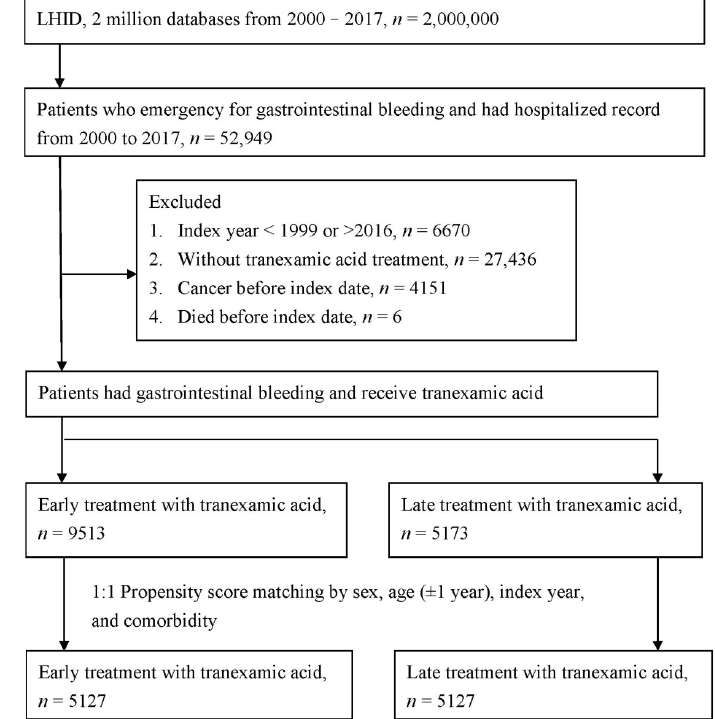
Figure 1. Study Figure 1. Study flowchart. Table 1. Baseline characteristics among study groups.